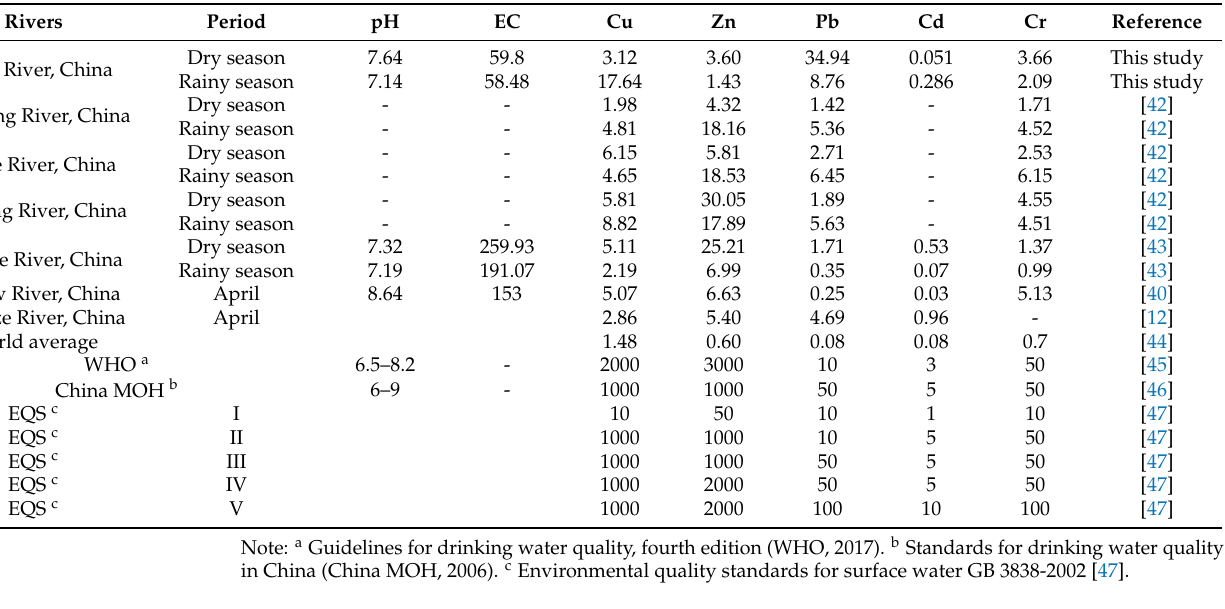
Table 2. The mean values of pH, EC ( µ S/cm), and heavy metal concentrations ( µ g/L) in the Fuhe River and the surrounding rivers.